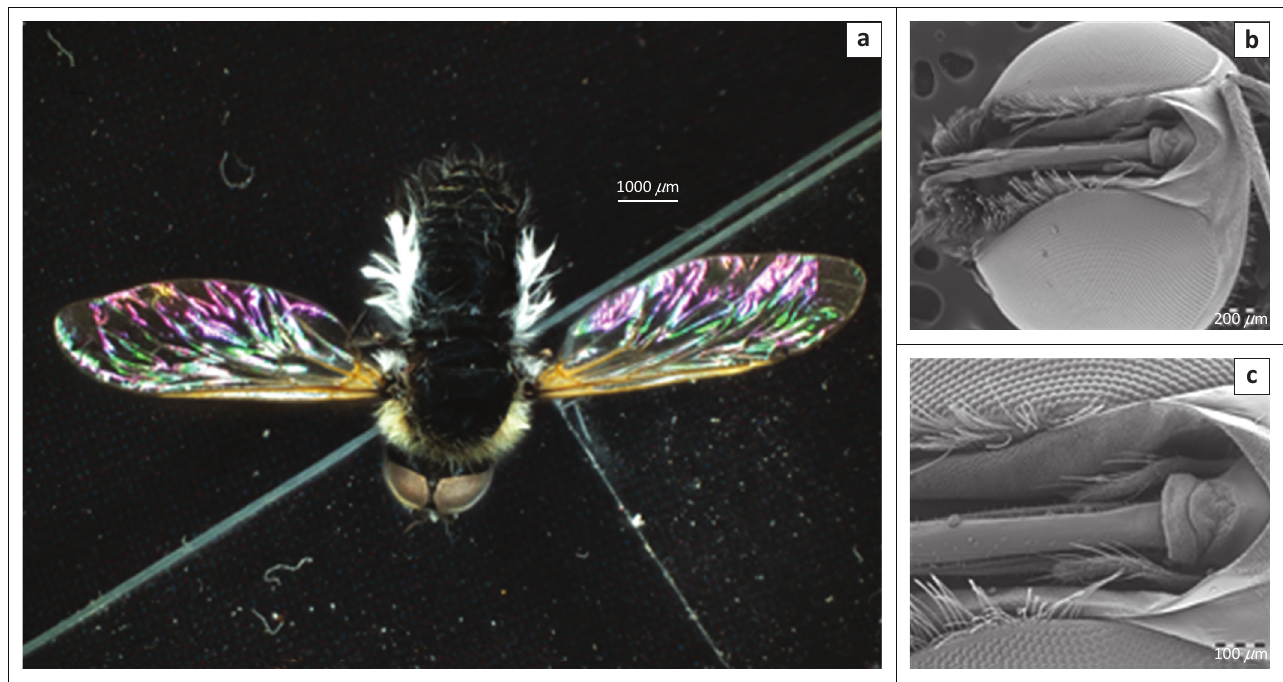
FIGURE 4: (a) Stereomicrograph of Notolomatia sp. (Bombyliidae). Scanning electron micrographs of several Frithia humilis pollen grains on the eyes (b) and proboscis